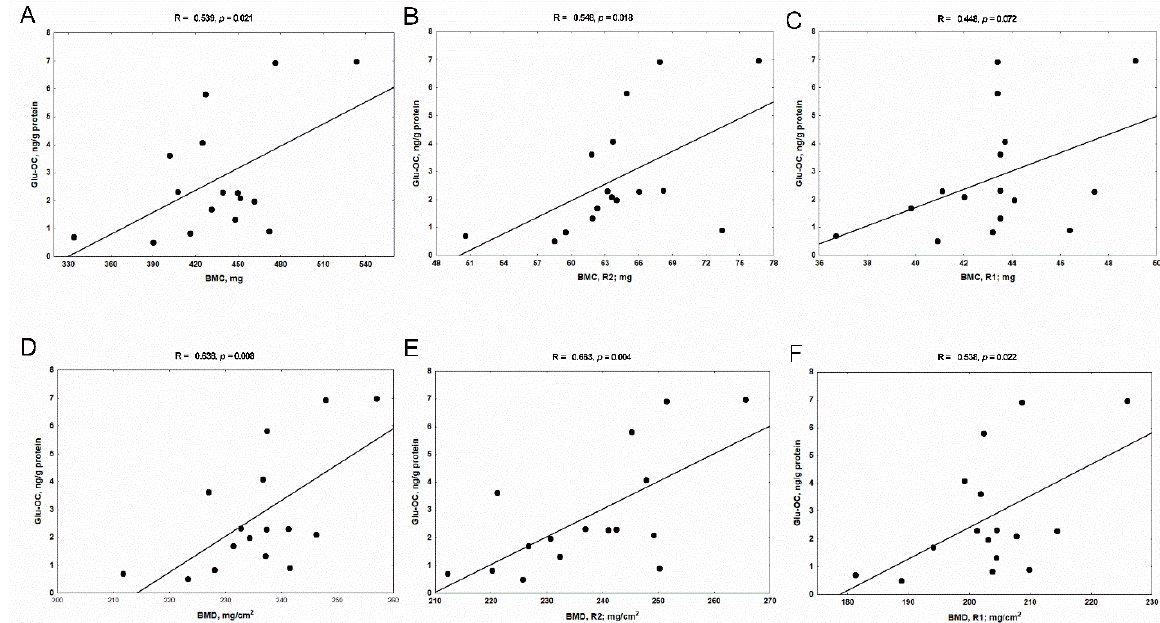
Figure 9. The associations between undercarboxylated osteocalcin (Glu-OC) levels in cortical bone tissue and whole BMC, BMD ( A , D ), diaphyseal BMC, BMD ( B , E ) and metaphyseal BMC, BMD ( C , F ) of femurs of rats with chronic kidney disease (CKD). BMC—bone mineral content; BMD—bone mineral density; R1—metaphyseal area; R2—diaphyseal area of femur.